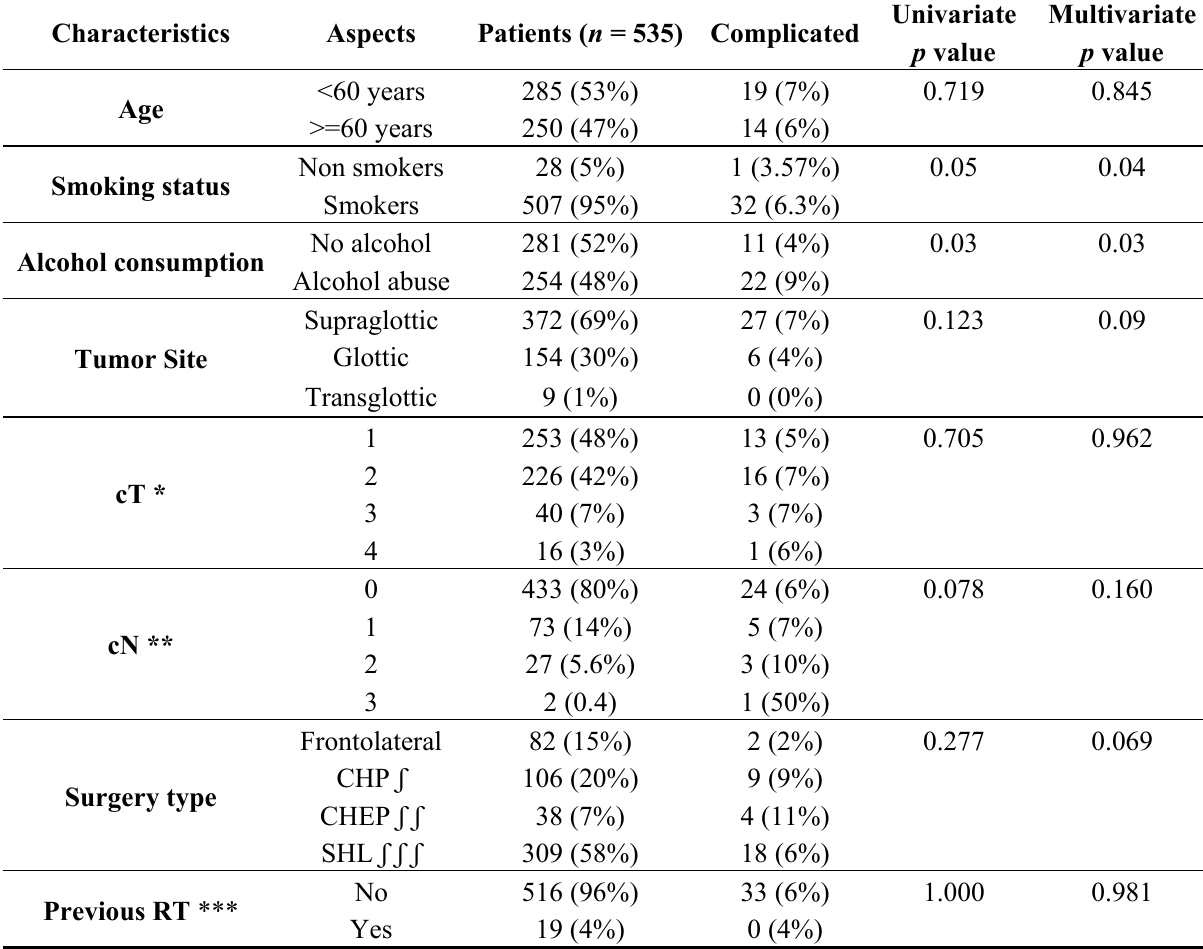
Table 4. Factors predictive for local